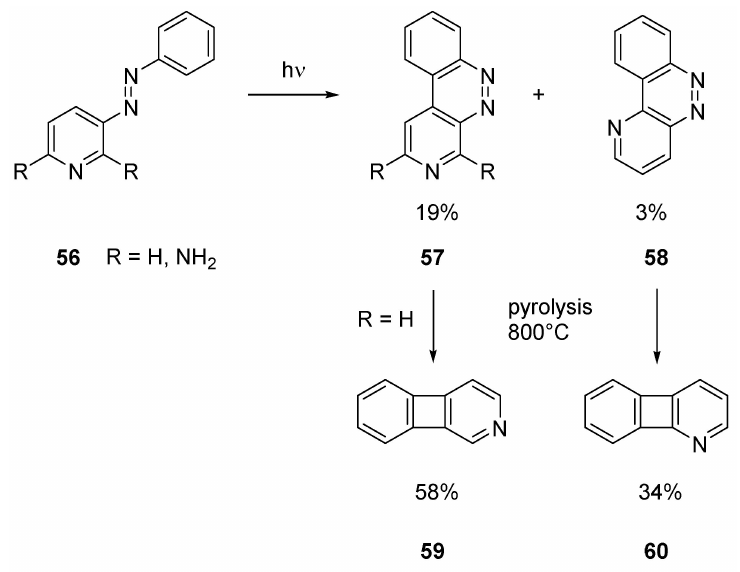
Scheme 13. Pyridocinnolines by